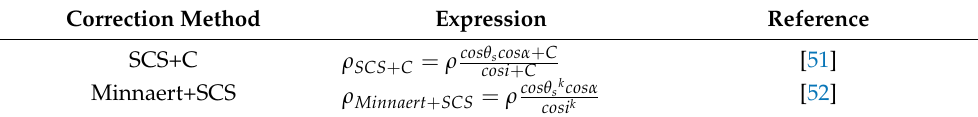
Table 3. Expressions of the methods for comparison.